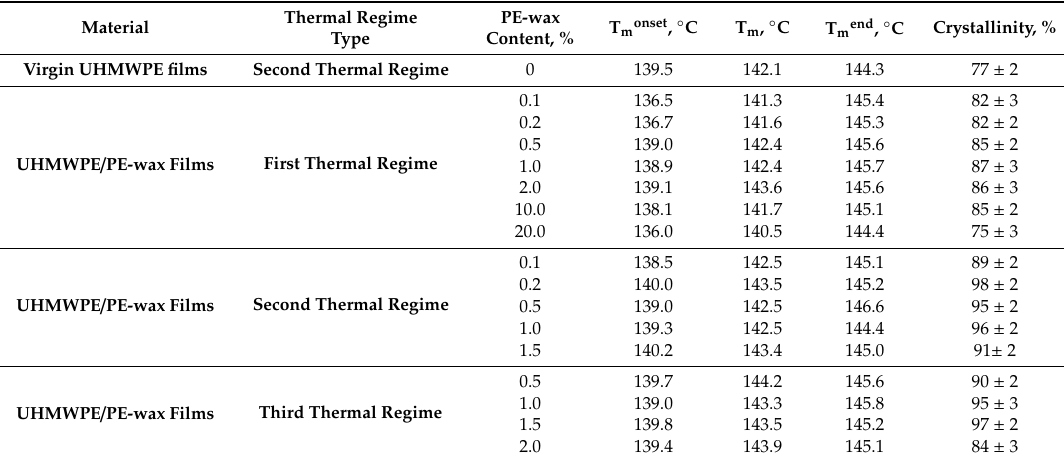
Table 4. DSC test results for the UHMWPE / PE-wax films depending on the PE-wax content for all thermal regimes ( ± the standard